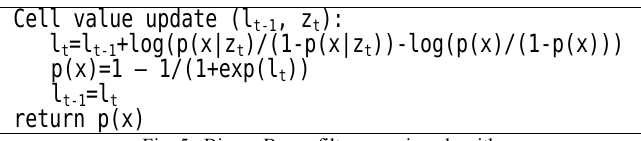
Fig. 5. Binary Bayes filter mapping